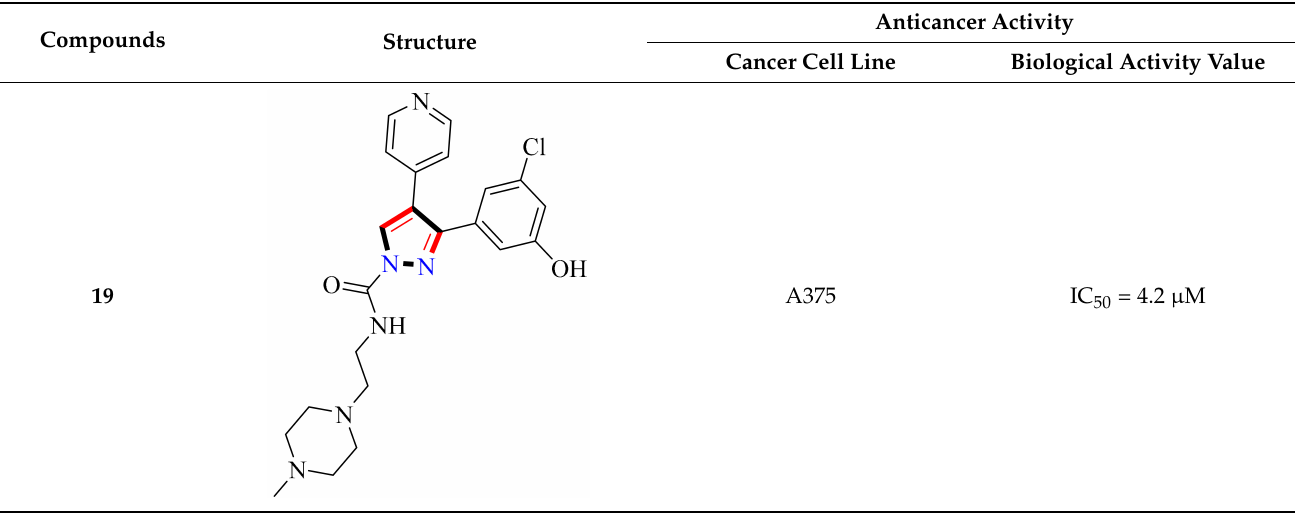
Table 3. Representative compound structure 19 to 30 and their anticancer